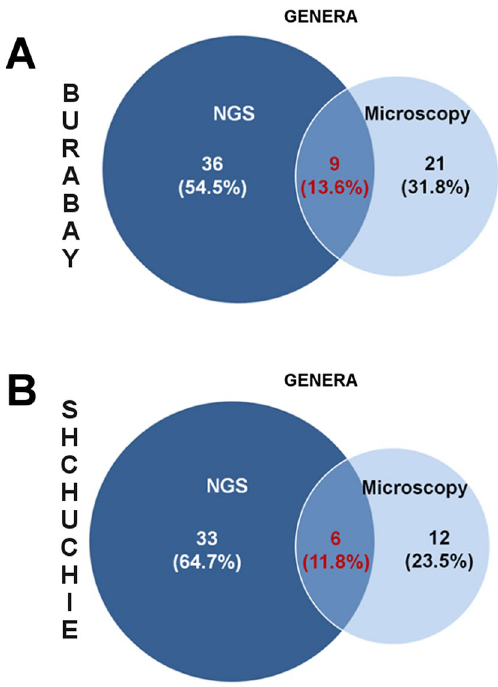
Figure 6. Shared genera for prokaryotic phytoplankton in Lakes Burabay and Shchuchie detected by microscopy approach and next-generation sequencing of 16S rRNA gene. ( A , B ) Venn diagrams for similar and unique